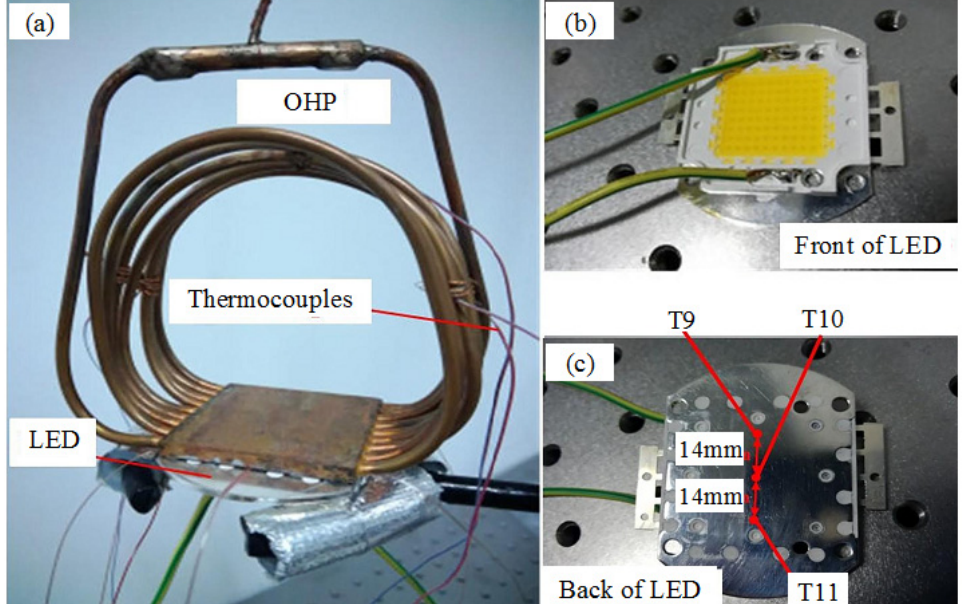
Figure 7. LED heat sink and PHP: ( a ) LED heat sink; ( b ) Front of LED chips; ( c ) Back of LED chips (T9, T10, and T11 are the LED backside temperatures obtained by three K-type thermocouples) [87]. Wang et al. (2019).